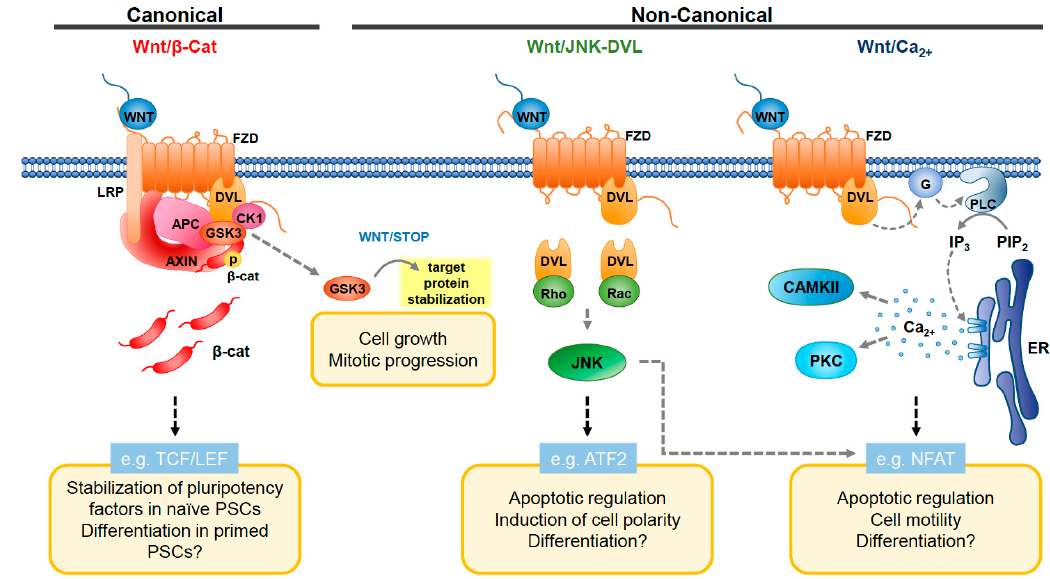
Figure 1. Canonical and non-canonical Wnt pathways and their effects in pluripotent stem cells (PSCs). Canonical Wnt/ β -catenin pathway activation ( left ) starts with WNT binding Frizzled (FZD) receptor and the co-receptor LRP5/6, which induces the recruitment of Dishevelled (DVL)and inhibits the β -catenin destruction complex formed by AXIN, APC, GSK3, and CK1. This inhibition causes the accumulation of β -catenin, which is no longer phosphorylated by the destruction complex. β -catenin then translocates to the nucleus where it activates transcription of Wnt target genes. A divergent pathway involving GSK3 participates in the stabilization of proteins important in mitotic progression (Wnt/Stabilization of proteins (STOP) pathway). In the non-canonical Wnt/DVL-JNK pathway ( middle ), DVL activation by Wnt induces the activation of Rho and Rac small guanosine triphosphatases (GTPases). Activation of these proteins signals through JNK. In the non-canonical Wnt/Ca 2+ pathway ( right ), the binding of WNT to FZD activates the heterotrimeric G-proteins. These signal through phospholipase C (PLC) and inositol 1,4,5-triphosphate (IP 3 ) to induce the release of intracellular Ca 2+ and the activation of Protein Kinase C (PKC) and Ca 2+ /calmodulin-dependent protein kinase II (CaMKII). NFAT: Nuclear factor of activated T-cells; APC: adenomatosis polyposis coli; ER: Endoplasmic reticulum; IP 3 : Inositol 1,4,5-triphosphate; PIP 2 : Phosphatidylinositol 4,5 ‐